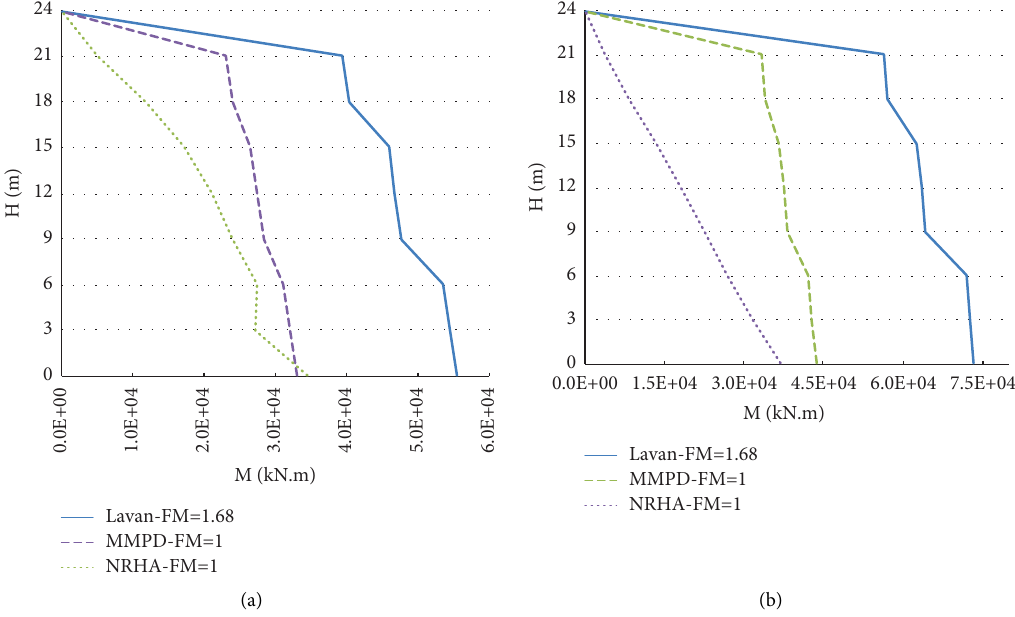
Figure 24: NRHA fexural moment demands and MMPD fexural capacities of walls for building B1 under BIGBEAR record and Wilkinson’s displacement response spectra: (a) 20cm wall and (b) 30cm